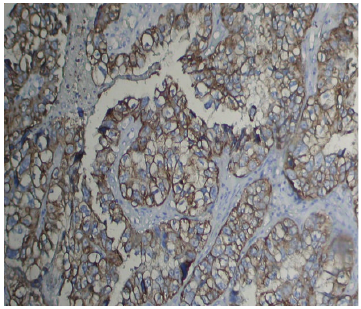
Figure 1: H&E staining showing squamous cell carcinoma. Org. Mag. × 400.